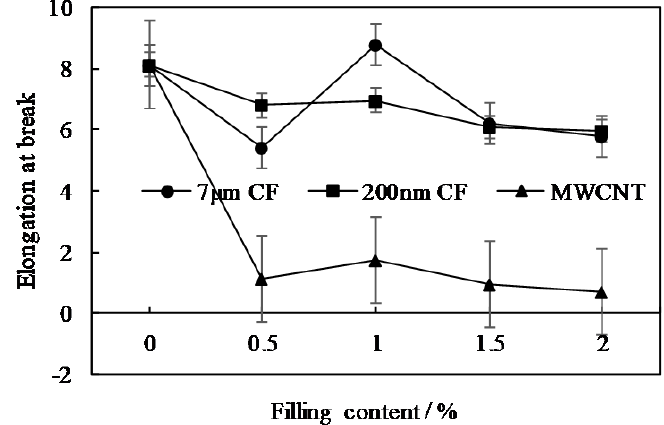
Figure 9. Tensile elongation at break of micro/nano CF and MWCNT modified PTFE composites.